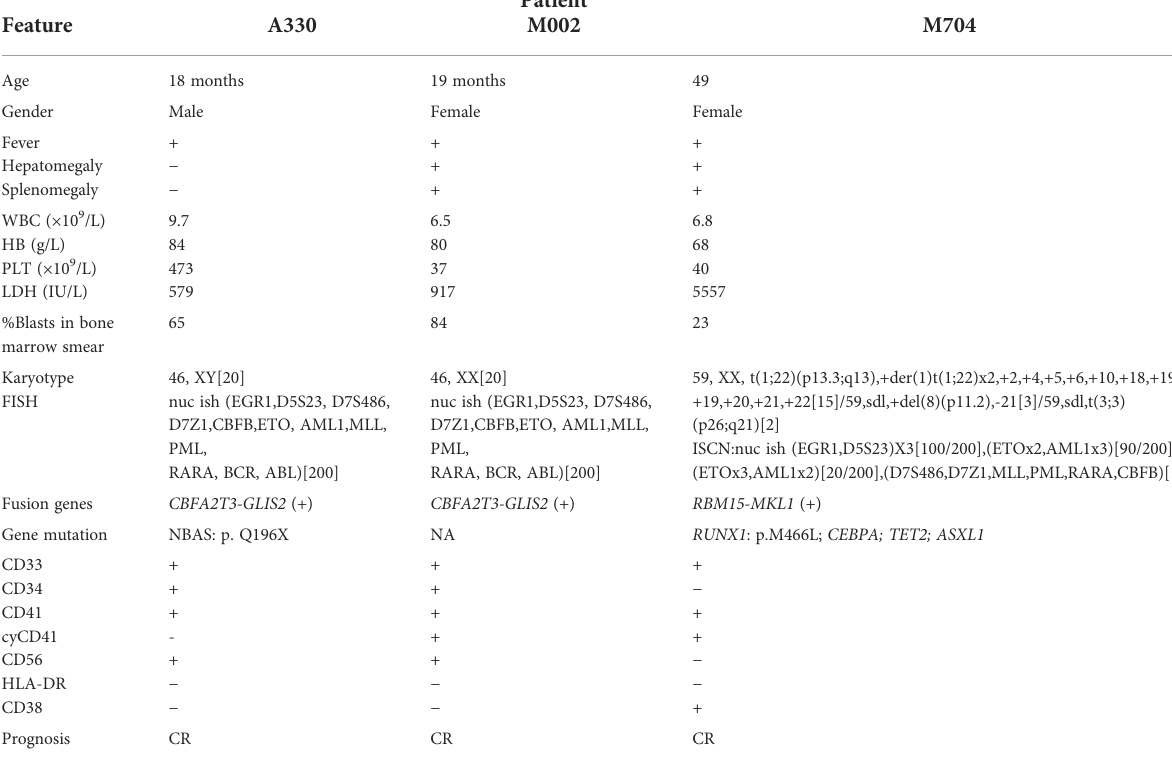
TABLE 1 The clinical characterizations of the three non-DS-AMKL